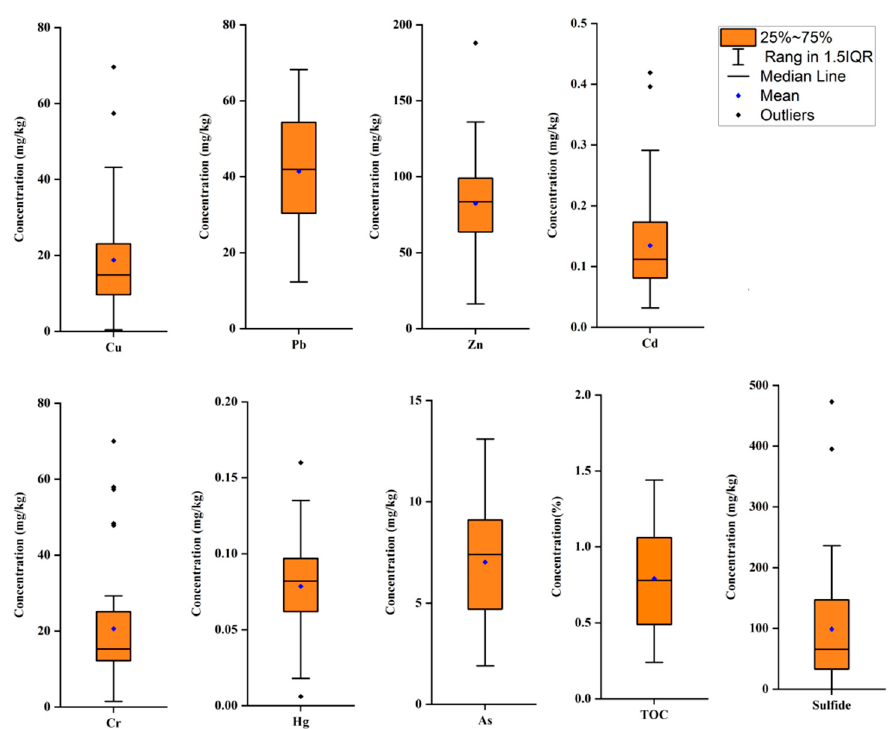
Figure 2. Box diagram showing the average contents of PTEs, TOC and Sulfide in Xiamen